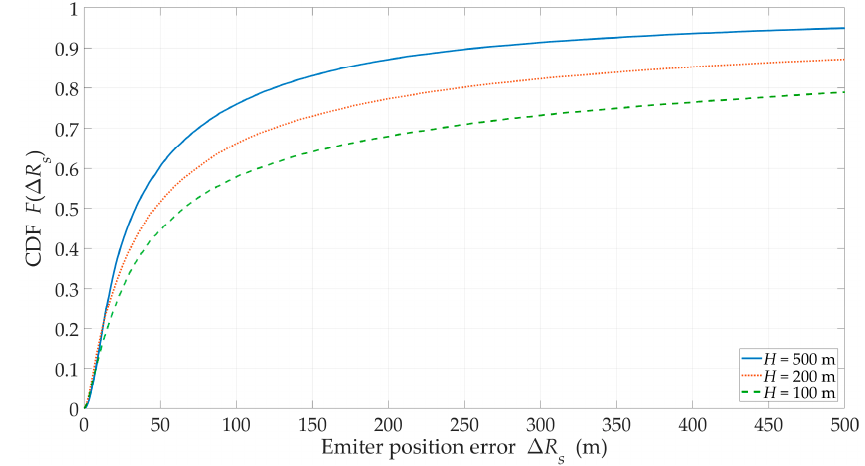
Figure 12. CDFs of the location error versus the different flight altitudes for a suburban area. Table 2. E ff ectiveness metrics for the di ff erent flight